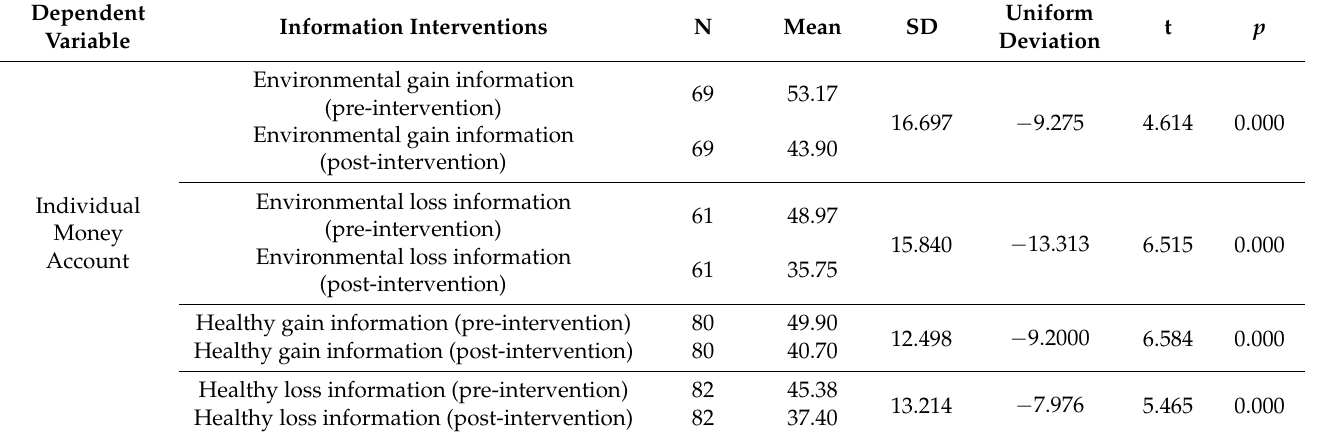
Table 5. Table of paired sample t -test results of different information frameworks on different spheres of the